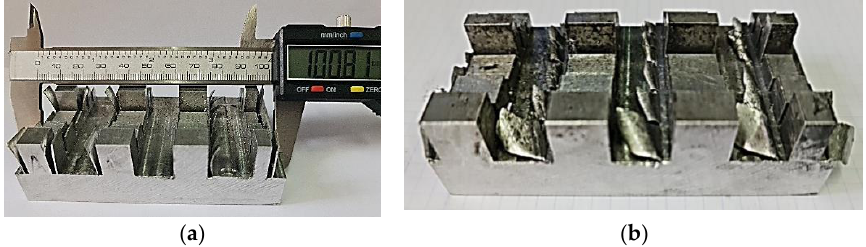
Figure 7. Images of the results obtained for different thicknesses of the disc cutter ( a ) t t min = 1.2 mm; ( b ) t t max = 2 mm; the deviation from the correct form of the thin wall was so high that the curvature of the wall led to touching the bottom of the groove or the other wall of the groove.